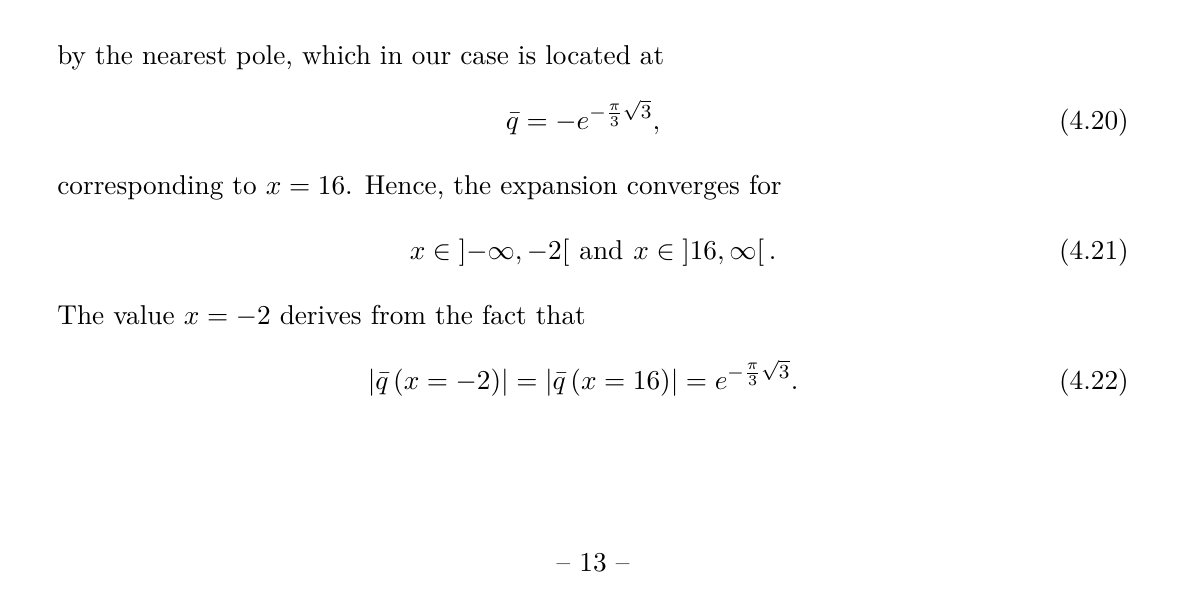
Figure 4 . The path in τ -space and in ¯ q